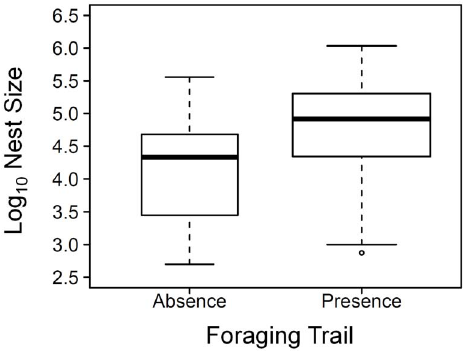
Fig. 4. The relationship between nest size and the presence or absence of foraging trail. Boxplots show the range, quartiles, medium and outliers of the data. Boxplot width is proportional to the square root of sample size. This figure does not take colony identity in account, but the full analysis does (linear mix-effect